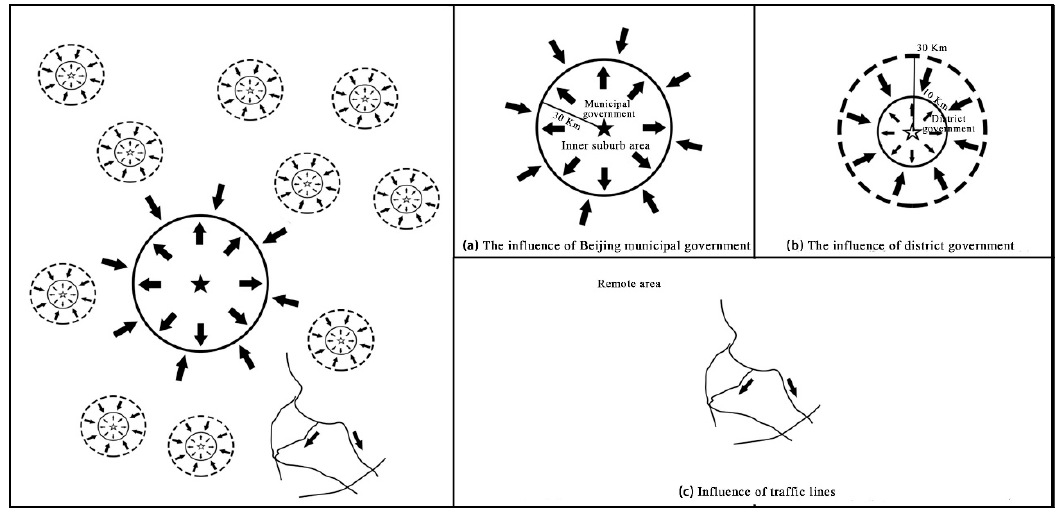
Figure 15. Urban land spatial expansion pattern in Beijing. ( a ) the influence of Beijing municipal government; ( b ) the influence of district governments; and ( c ) the influence of traffic lines.